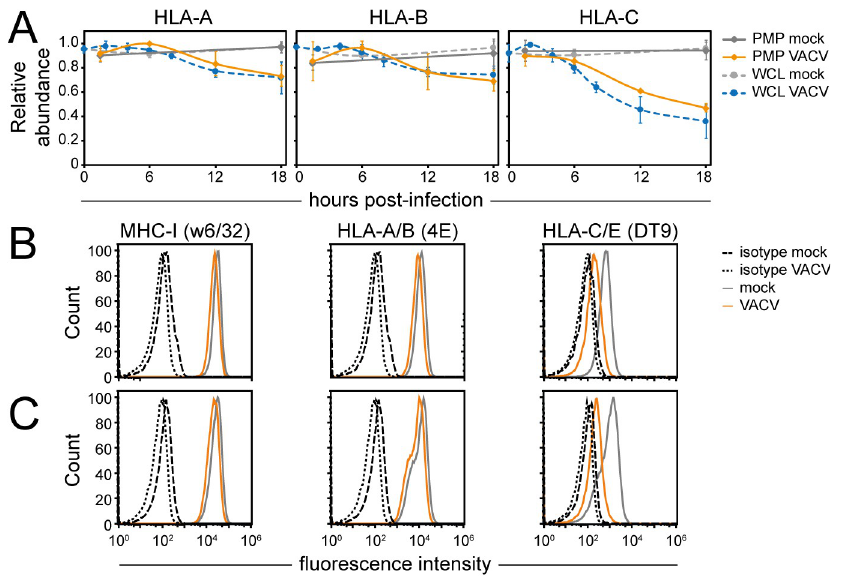
Fig 3. Selective downregulation of HLA-C from the PM during VACV infection. ( A ) Temporal profiles were generated only using peptides belonging uniquely to each of the indicated HLA-I heavy chains. Data are represented as mean ± SD (PMP n = 2; WCL [9] n = 3, # WCL n < 3). ( B-C ) Cell surface downregulation of selected proteins during VACV infection (MOI 5) was confirmed by flow cytometry in HFFF-TERTs ( B ) or HeLa cells ( C ) at 15-18hpi. Results are representative of at least 2 independent